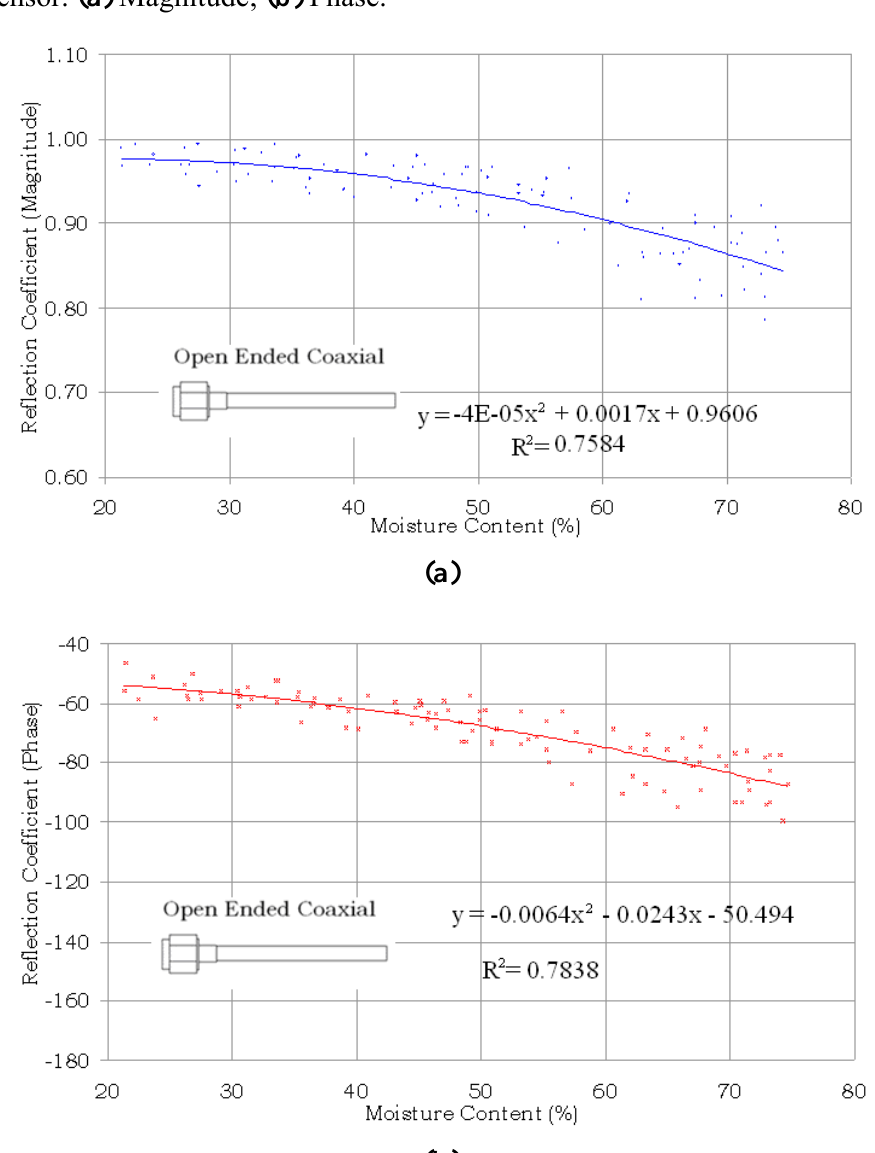
with moisture content using open ended 11